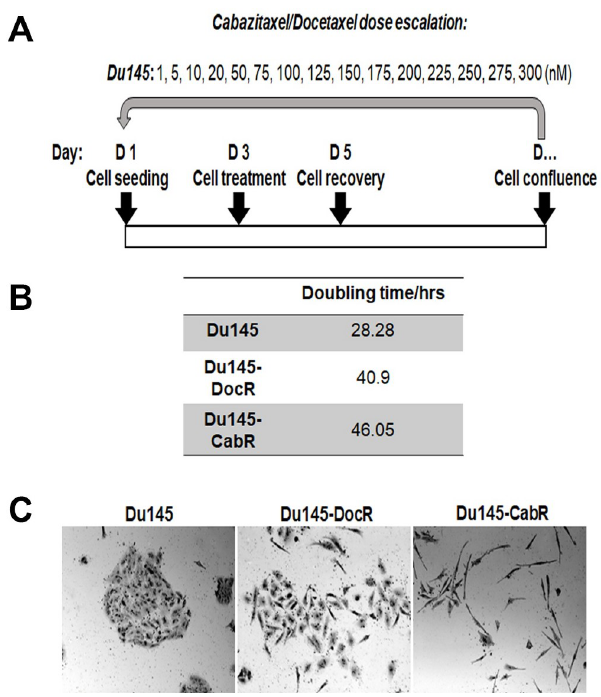
Fig 1. Establishment of taxanes resistant cell lines (A) Treatment scheme for the Du145 cells. (B) Doubling times of the age-matched, DocR and CabR derivative cell lines. (C) Cell morphology as observed under a light microscopy using a 20x objective. Cells doubling time was calculated over a 9 consecutive day period using the formula N(t) = C2^t/d where N(t) = number of objects at time t, d = Doubling period, C = initial number of objects and t = time [46].